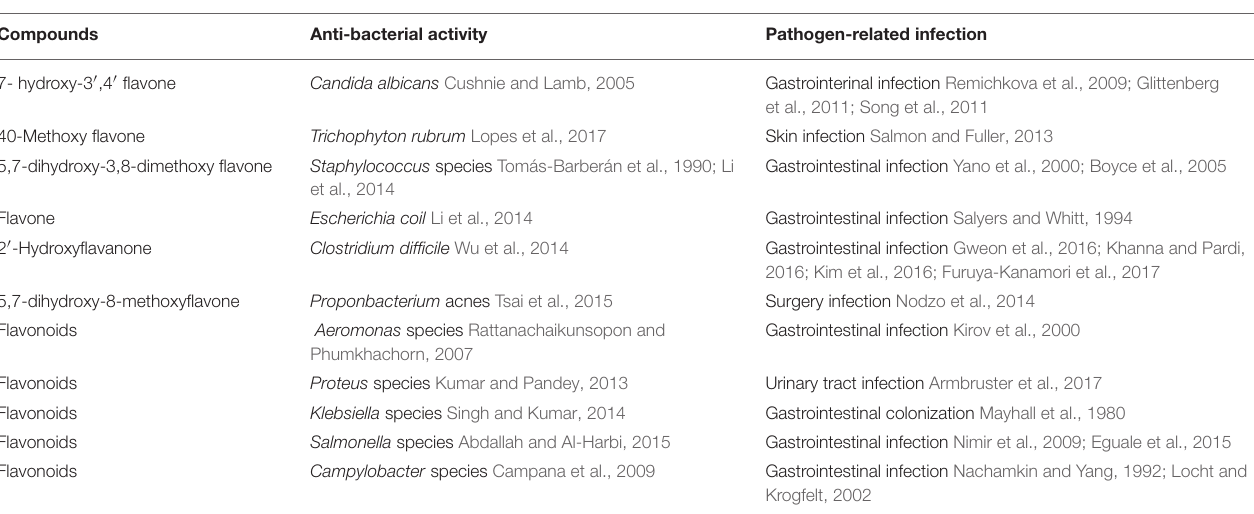
TABLE 5 | The pathogens related infection inhibited by